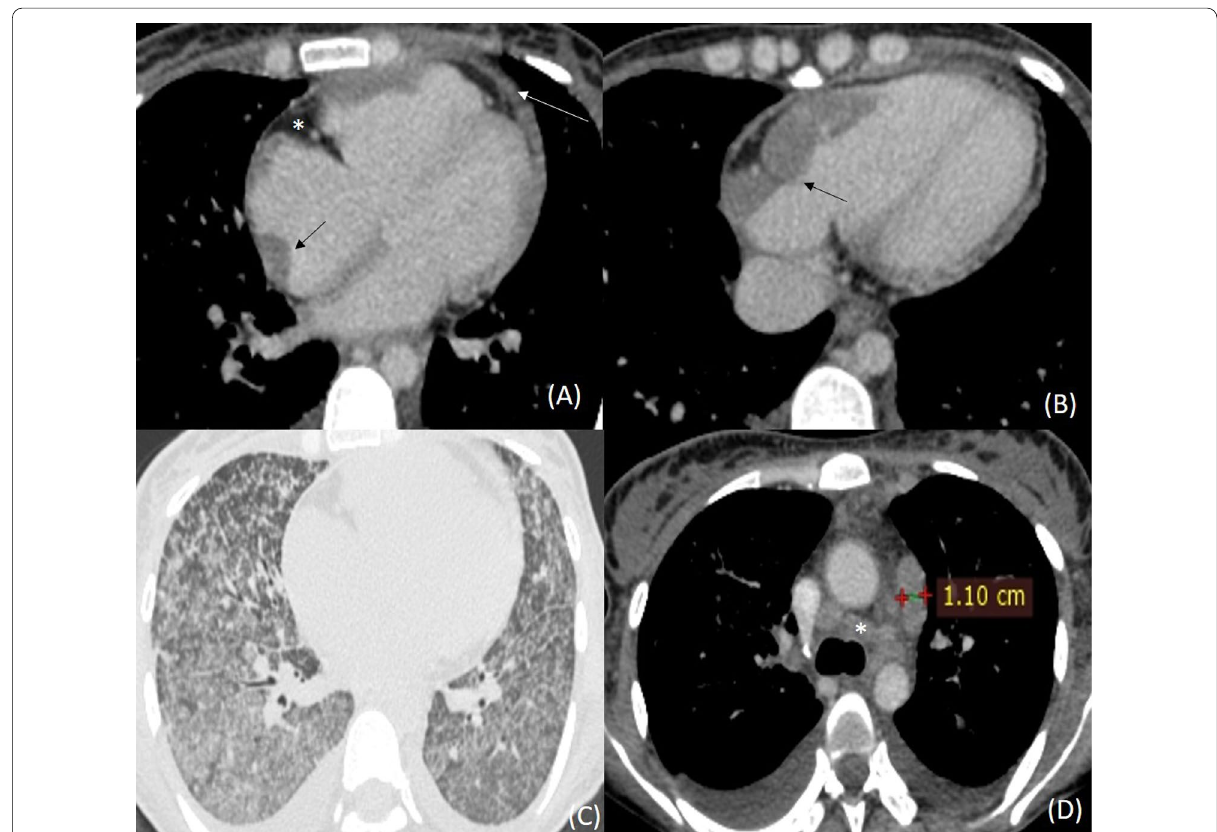
Fig. 6 Cardiac tuberculosis with myocardial and pericardial involvement. CT images of a 42-year-old female show nodular thickening of the right atrial and ventricular myocardium (black arrow in A and B ), thickening of pericardium (white arrow in A ) and epicardial fat pad (* in A ), lung window shows miliary nodules in bilateral lungs ( C ) and mediastinal window shows multiple enlarged mediastinal nodes (* in D ) and bilateral pleural effusion ( D